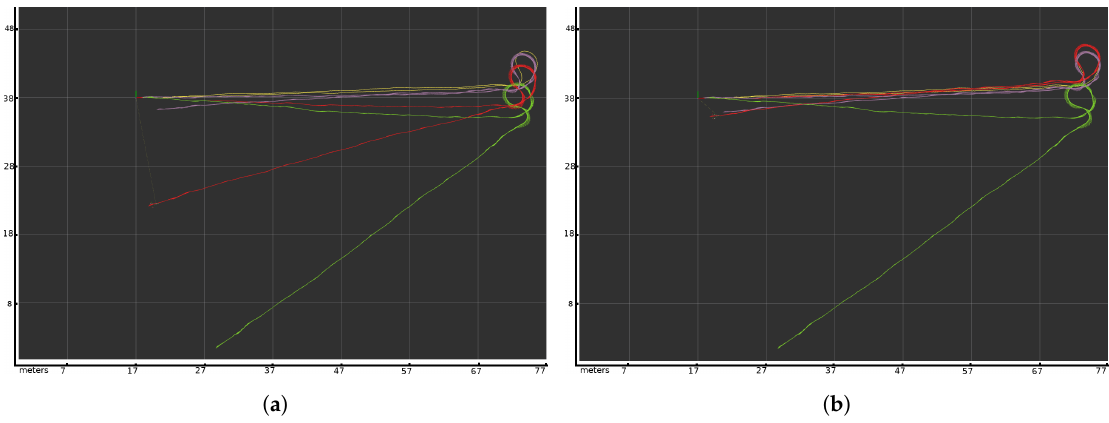
Figure 12. Experiments with static and variable covariance. Green line, path based on the odometry. Purple line, path based on the laser scan matching algorithm. Yellow line, ground truth based on the Velodyne sensor. Red line, the fusion algorithm with static covariance ( a ) and with variable covariance ( b ). Each square on the grid represents 10 m. ( a ) Localization with odometric static covariance set to a medium value. ( b ) Localization with Doppler effect variable covariance in the odometric